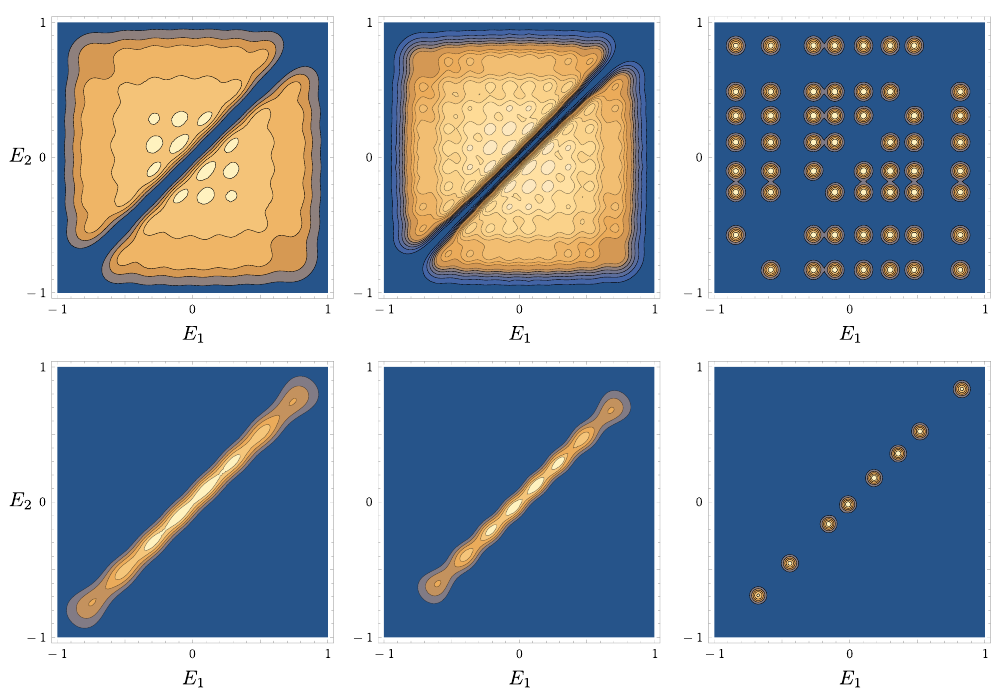
q (top) and spectral covariance T p E , E 1 2